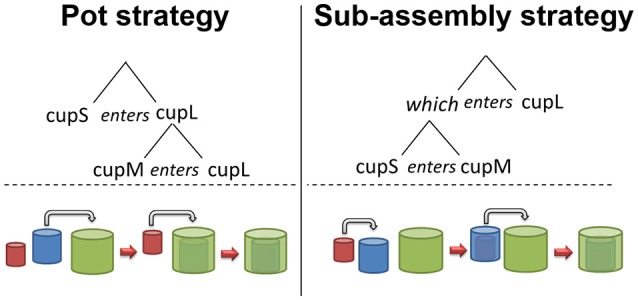
Two strategies of action grammar (adapted from Greenfield et al., 1972).